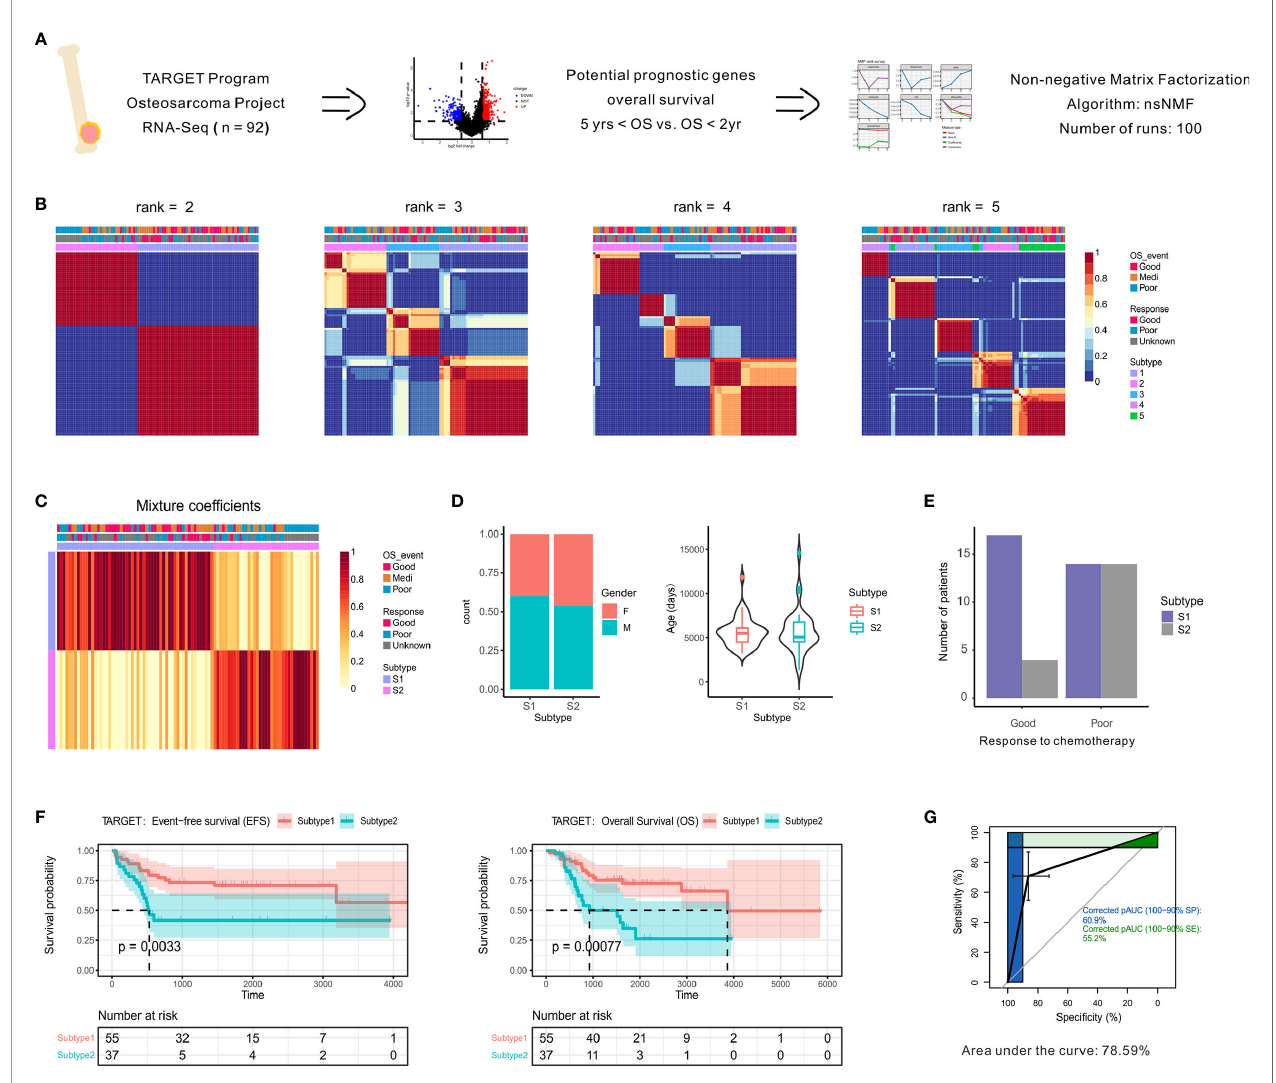
FIGURE 1 | Identi fi cation of prognostic molecule subtypes in the OSA tumor microenvironment. (A) Schematic fl ow diagram of the analytic procedures used for cluster analysis. (B) Nonnegative matrix factorization (NMF) classi fi cation with rank K from 2 to 5 identi fi es bases consistent with the prognostic signi fi cance subgroups. (C) Heatmap of the metagene expression pro fi les matrix. (D) Patient characteristics between two subtypes of patients (S1 and S2). (E) Number of patients with different chemotherapy responses between the two subtypes. (F) Kaplan-Meier event-free survival and overall survival curves for patients with OSA demonstrating signi fi cant differences in survival when separated into subgroups. (G) Receiver operating characteristic curve of